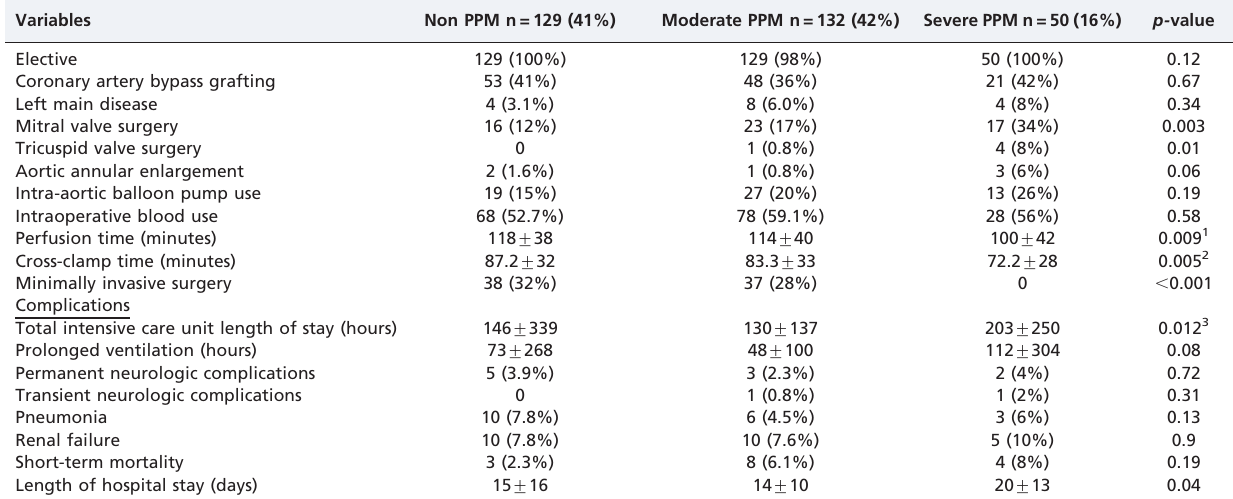
Table 2 - Operative Data.